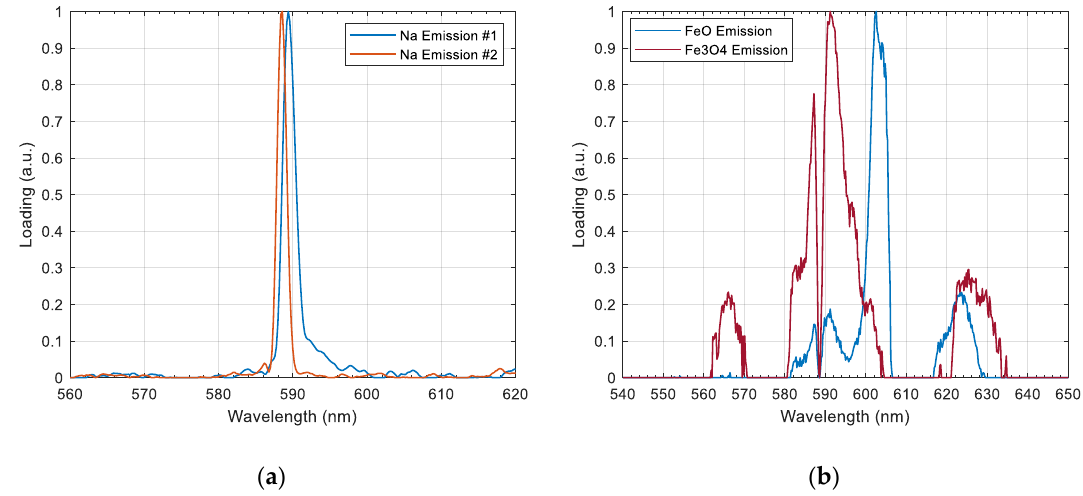
Figure 7. Discontinuities profile of Conc. A (orange) and CpyF (blue). Thus, to obtain a spectral profile associated with copper oxides, the spectra of the sample Conc. A were selected because they present greater irradiance intensity. MCR-ALS can perform multiset analysis of data organized in a single matrix [25] and, therefore, for this study, we proceeded to create a matrix in the range of 540 to 650 nm that contains the discontinuous samples of the Conc. A sample and the spectral signals of sodium (Na), FeO, and Fe 3 O 4 were those obtained by Toro et al. [16] (Figure 8). The aim of this was to make the MCR-ALS algorithm separate the signals of the known species (FeO, Fe 3 O 4 , and sodium) from those that are not, including the copper oxide profile.